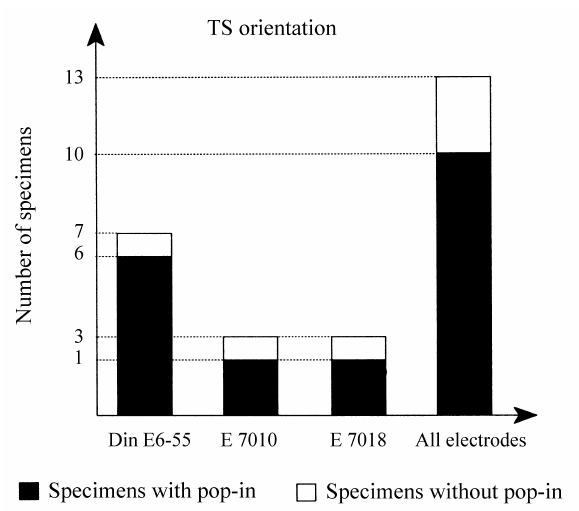
Figure 5. Frequency of pop-in in TS